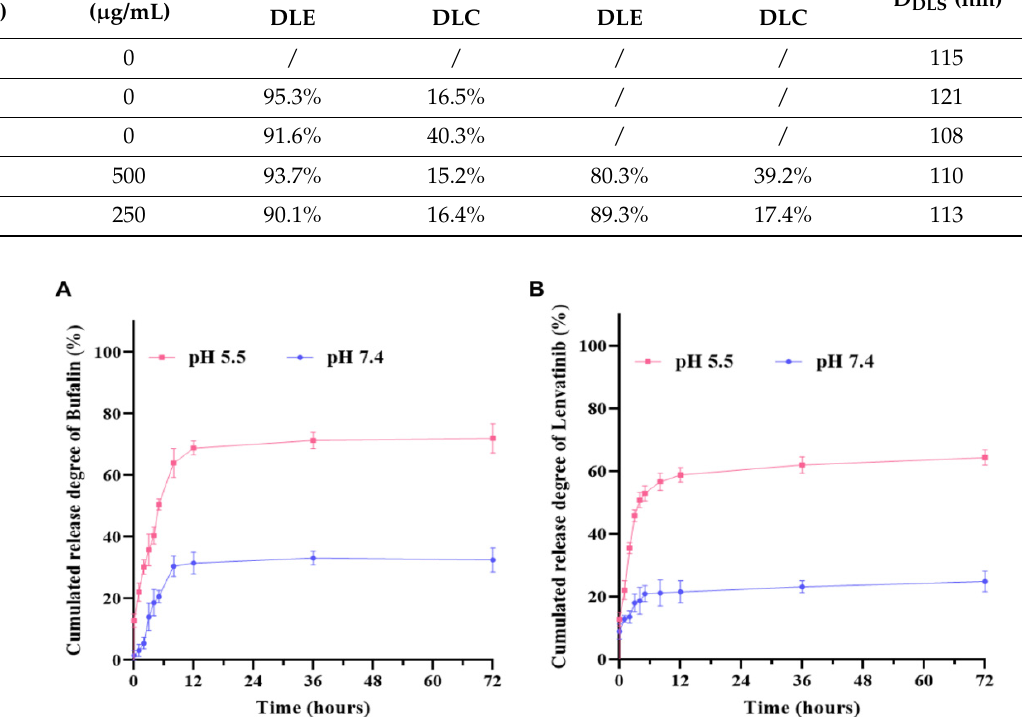
Figure 3. ( A ) Bu release profiles of Le/Bu@mSiO 2 -FA in different conditions; ( B ) Le release profiles of Le/Bu@mSiO 2 -FA in different conditions. Le, Lenvatinib; Bu, Bufalin; Le/Bu, Lenvatinib and Bufalin combination.